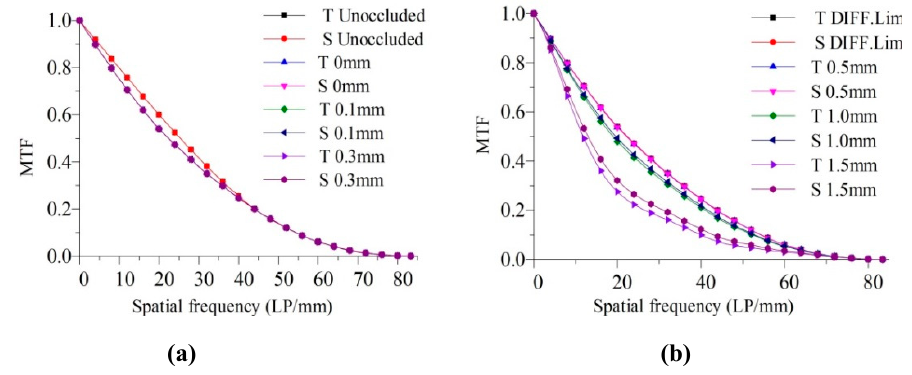
Figure 2. Comparison of modulation transfer function (MTF) curves for the mirror-based objective with the ideal MTF. (a) MTF curve for smaller fields; (b) MTF curves for larger fields.